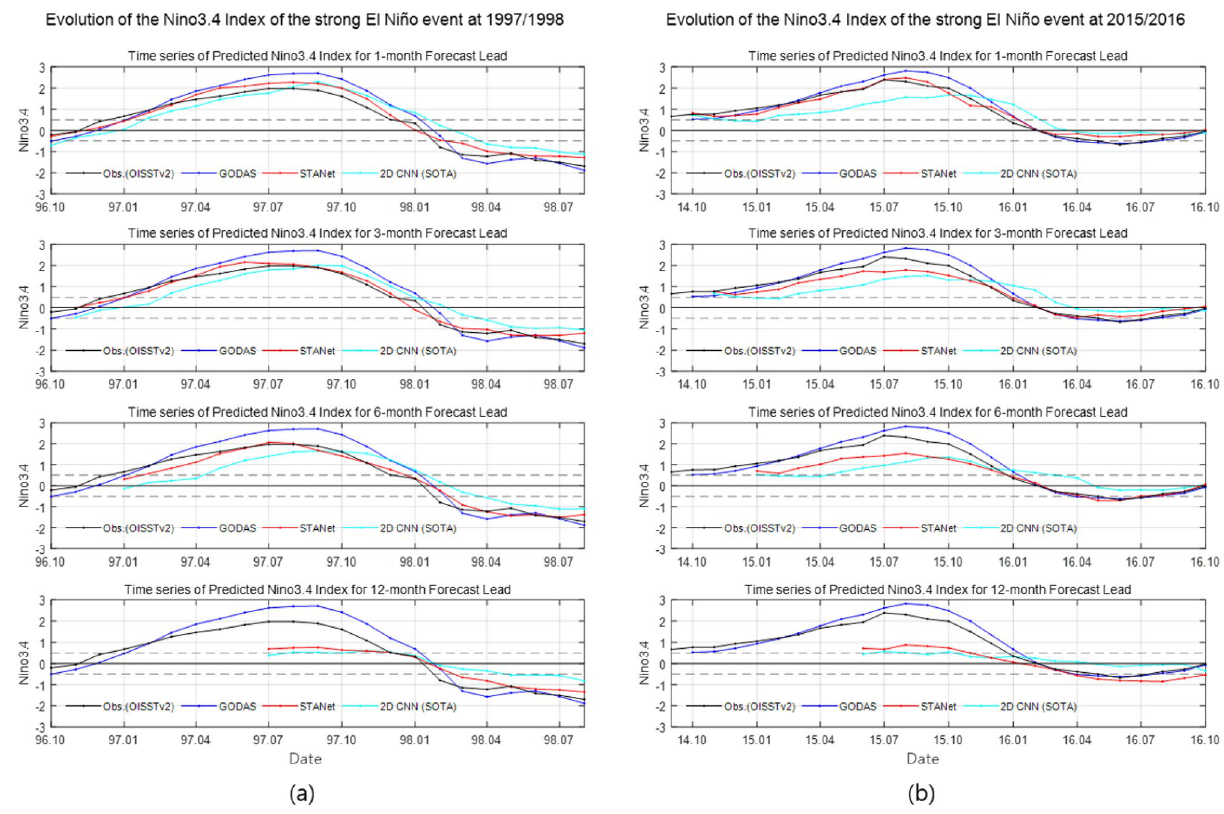
Figure 5. Evolution of the Nino3.4 index for two strong El Niño events of ( a ) 1997/1998 and ( b ) 2015/2016. From top to bottom, the time series with forecast lead time of 1-, 3-, 6-, and 12-month are shown,